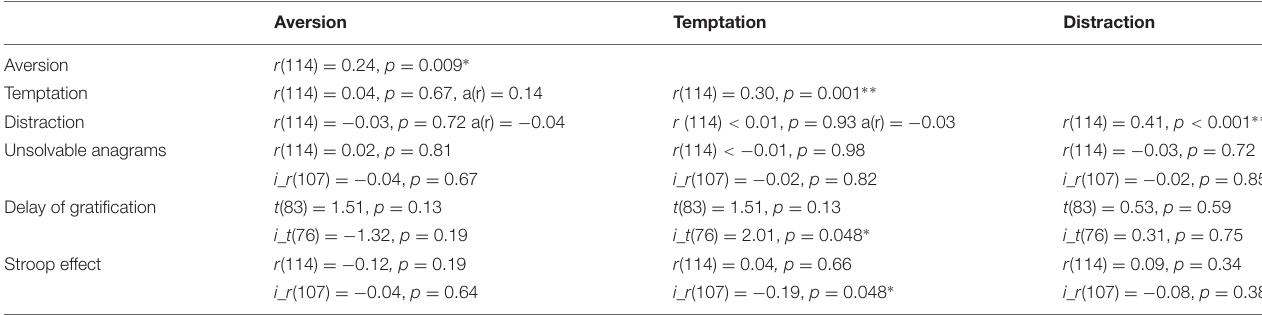
TABLE 3 | Split-half correlations of self-control sub-scores (aversion, temptation, and distraction RT scores) reveal significant reliability and are displayed along the first diagonal of the table. Aversion Temptation Distraction Aversion